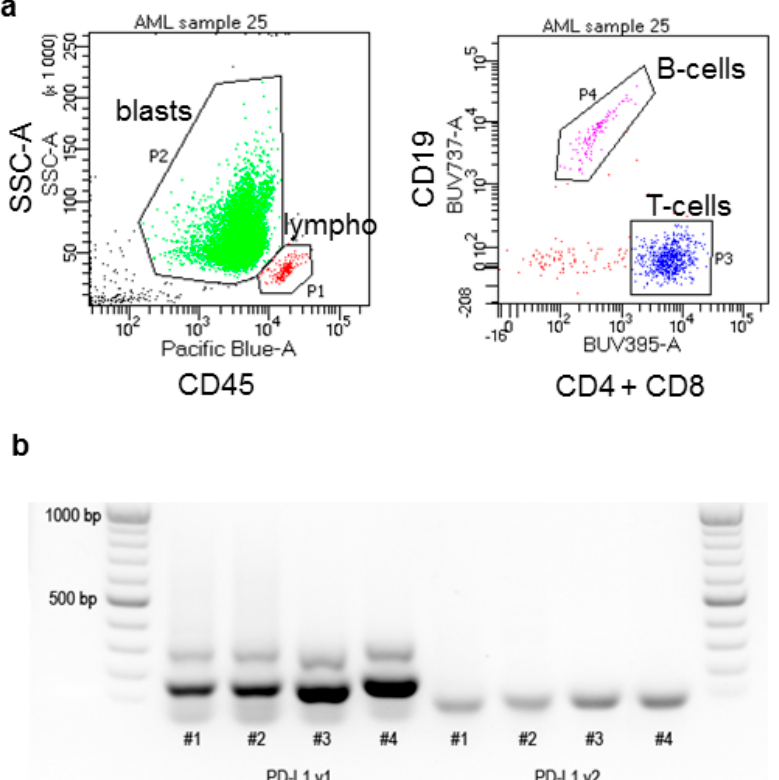
Figure 1. Illustration of the methods. ( a ) Examples of flow cytometry dotplots and the gating strategy. Blasts and lymphocytes were gated in CD45 / SSC dotplots (left). B-cells and T-cells were distinguished within the lymphocyte gate P1 (right). ( b ) Example of PCR products obtained using primers for v1 or v2 detection and resolved by gel electrophoresis.